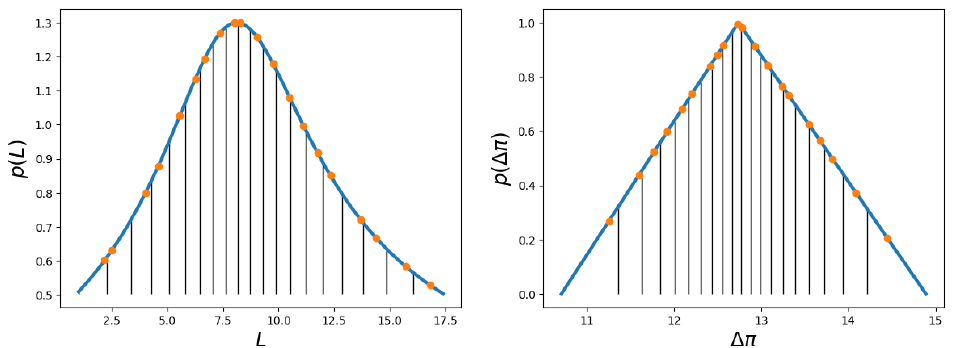
Figure 4. Sampling of parameters for the training set using the LHS method. The physiological range of the parameter values is divided into N equiprobable segments on each of which a random point is selected. Structure of sampling intervals for the lymph absorption rate parameter L ( left ) and the average oncotic pressure difference between blood and lymph ∆ π ( right